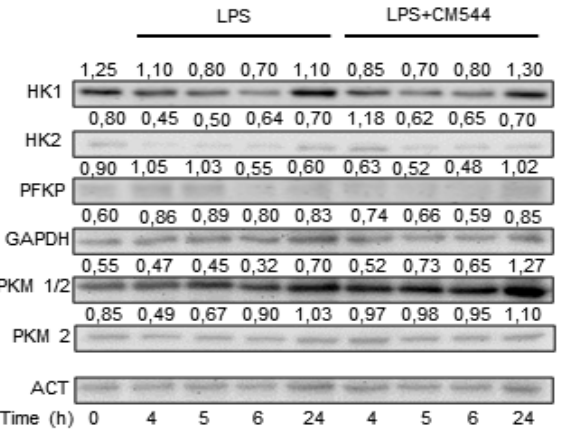
Figure 3. CM544 modulates enzyme of the glycolytic pathway. BV2 microglial cells were pre-treated with 10 µ g / mL LPS for 3 h and then 200 µ M CM544 was added for further 1 h, 2 h, 3 h, and 21 h. At each time point, cells were collected, and total extract used to analyze the enzyme of the glycolytic pathway by Western blotting. β -actin was used as loading control. Numbers above the images represent the ratio between respective protein and β -actin band intensity. The images are representative of one out of three separate experiments.